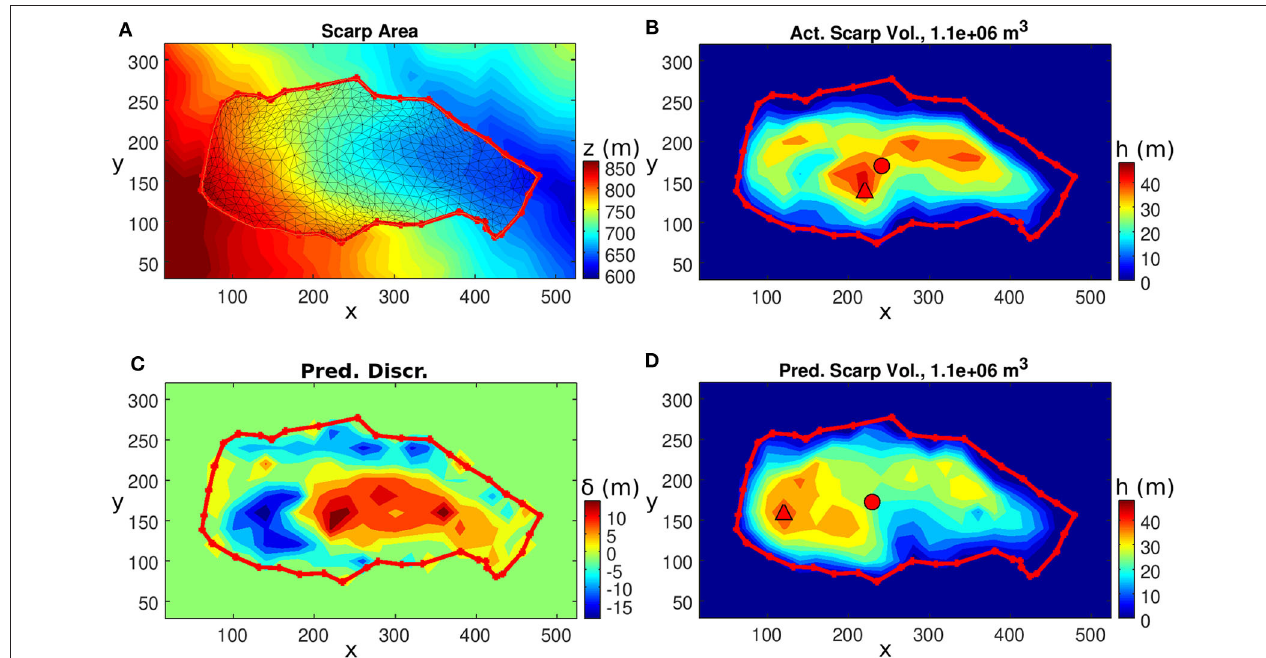
FIGURE 6 | Landslide FID5. Clockwise from the upper-left figure : (A) The topography, scarp outline and smooth minimal surface computational mesh. (B) The actual landslide depth. (C) The predicted landslide depth. (D) The prediction discrepancy δ ( x , y ). The solid red circle and triangle represent the gravity center and maximum depth location, respectively.